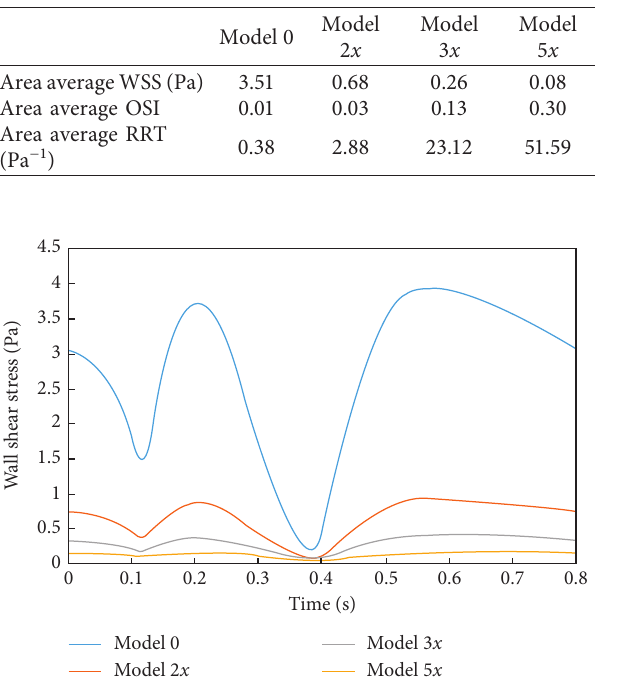
Table 2: Average values over a cardiac cycle for wall shear stress (WSS), the oscillatory shear index (OSI), and relative residence time (RRT) in the coronary artery aneurysm.